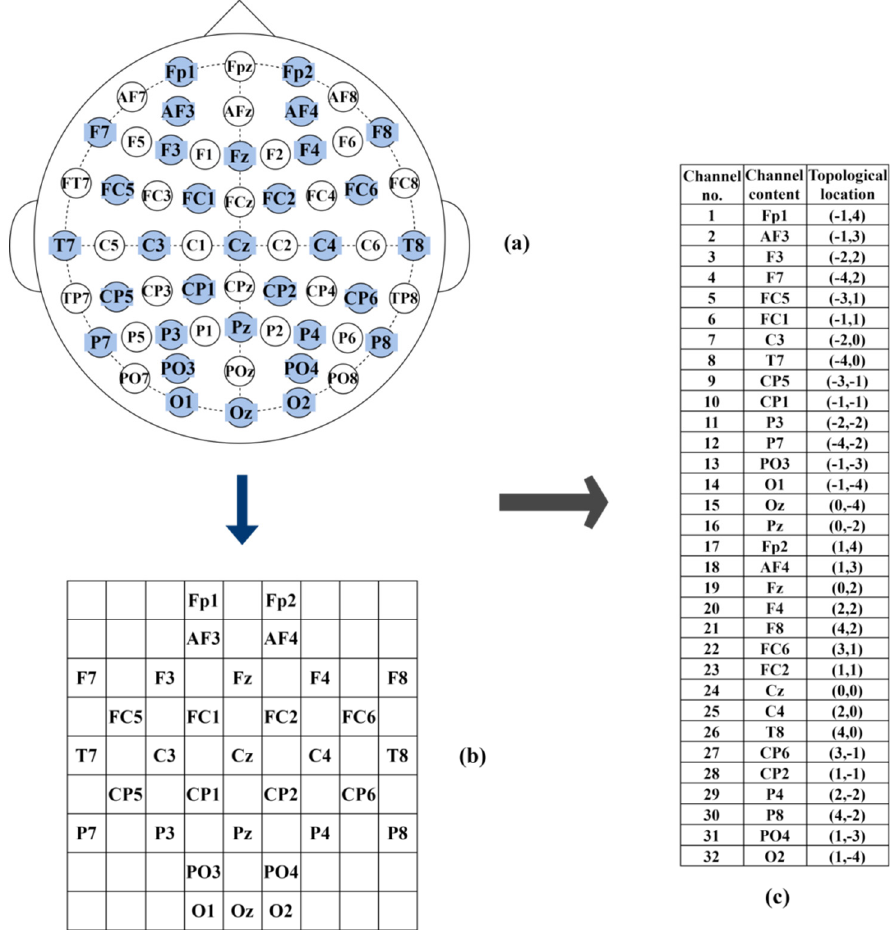
Figure 2. The mapping relationship between the spatial distribution of electrodes and the 2D topology of electrodes in the International 10–20 system: ( a ) The spatial distribution of the 32 electrodes in the International 10–20 system; ( b ) 9 × 9 electrode topology matrix; ( c ) Topological positions of the 32 electrodes.